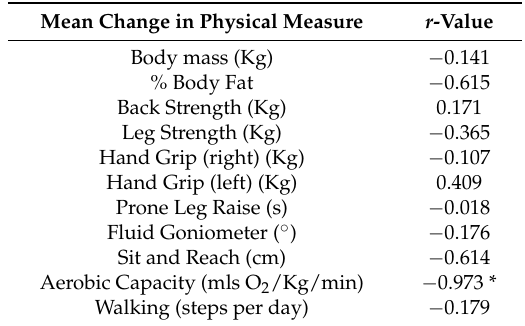
Table 6. Relationship between the change in MODQ and physiological